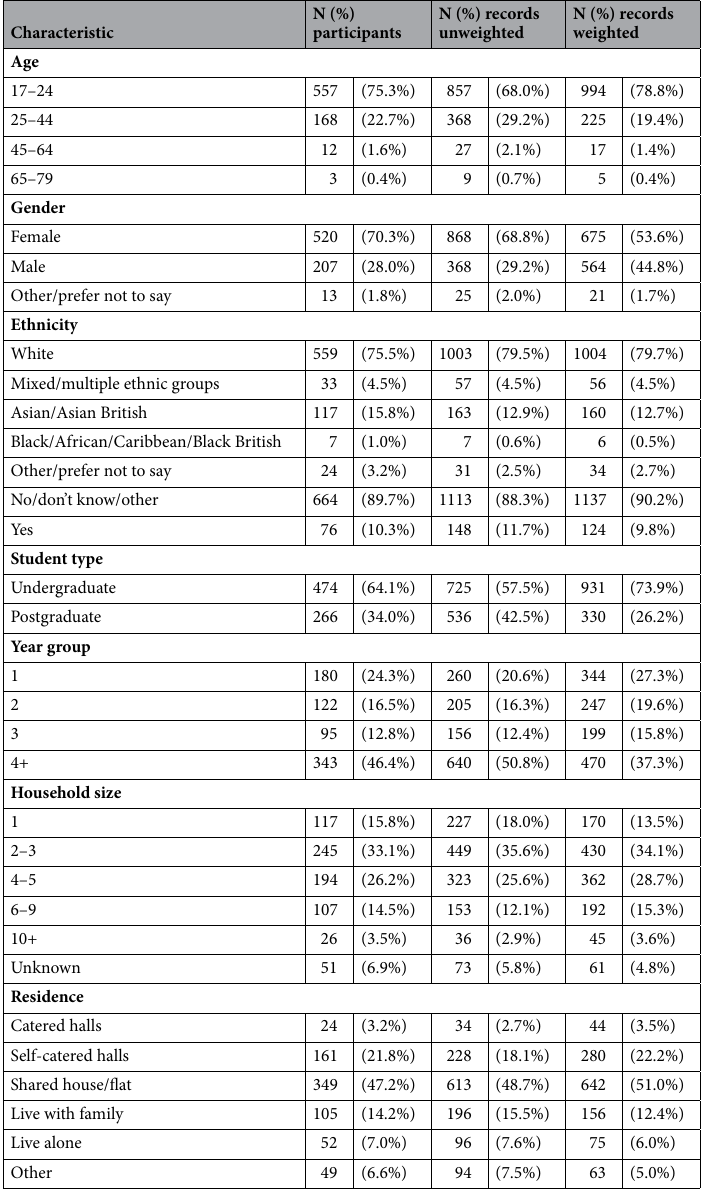
Table 1. Unweighted and weighted demographics of the 740 student participants and 1261 student